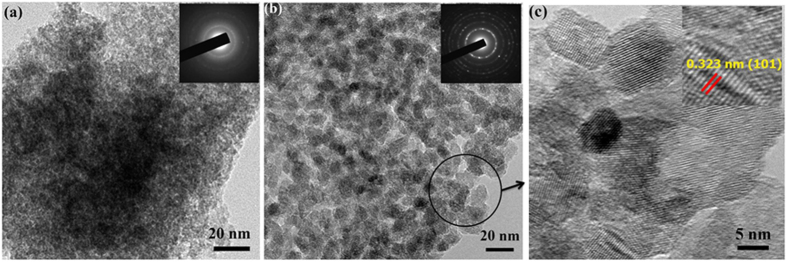
Comparison of TEM micrographs and SAED patterns for (a) as-prepared amorphous Ti(OH)4 and (b) TiO2 obtained after 15 days ageing in NH4F(aq) (c) HRTEM image of TiO2 showing dominance of (101) diffraction planes.